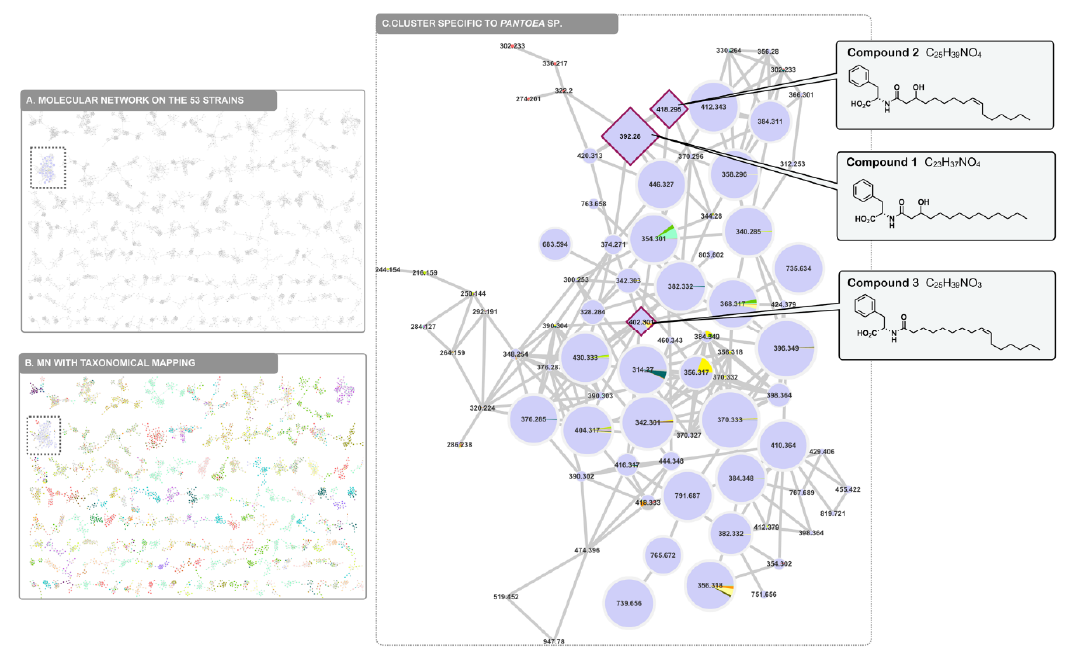
Figure 3. ( A ) Generation of a massive molecular network from the UHPLC-HRMS 2 analysis of 53 entomopathogenic microorganism extracts. ( B ) Taxonomical mapping showing a cluster containing ions mainly found in the Pantoea sp. extract. ( C ) Cluster of lipoaminoacids with compounds 1 , 2 , and 3 corresponding to compounds isolated from the Pantoea sp. extract.